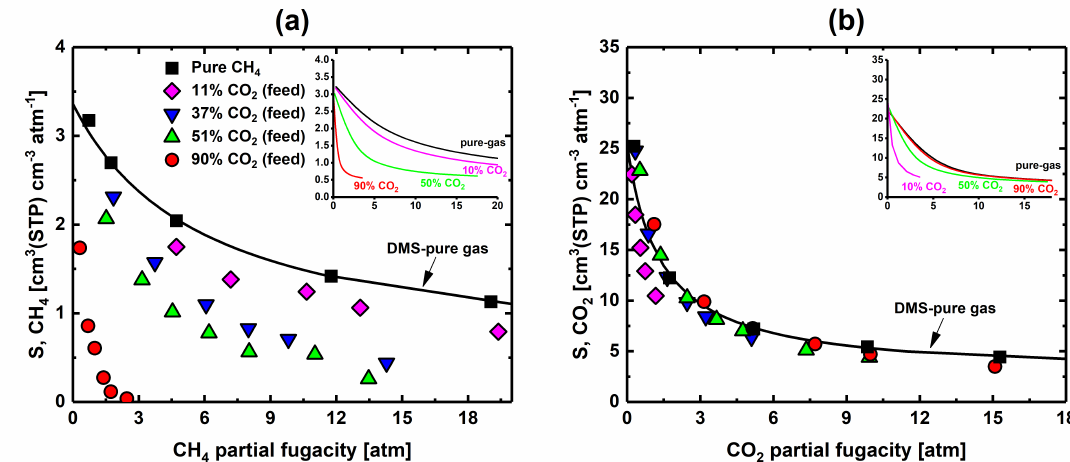
Figure 4. ( a ) Experimental CH 4 solubility coefficient vs. CH 4 fugacity and ( b ) CO 2 solubility coefficient vs. CO 2 fugacity of 6FDA-mPDA. The inset graphs report the solubility coefficient behavior of CH 4 and CO 2 at various equilibrium concentrations—these curves were predicted using the dual-mode sorption model extended to mixtures (DMS-mix) [35] and the pure-gas DMS sorption parameters (Table S1). Note that the feed mixture concentration is the parameter for the experimental data in ( a , b ), whereas the concentration at equilibrium is the parameter for the DMS-mix predictions (insert graphs); hence, the comparison between experimental data and predictions is qualitative (i.e., the DMS-mix curves guide the reader through the